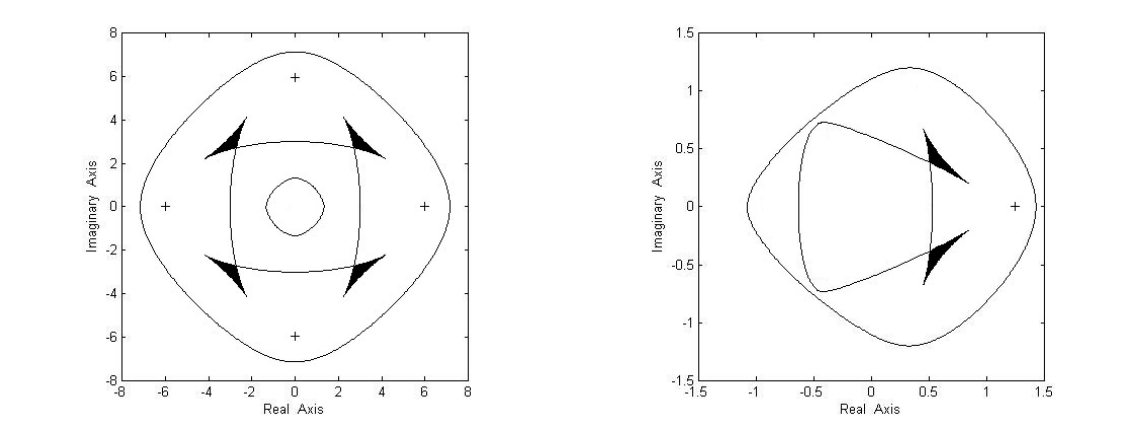
Figure 3. The sets F ( A ) ≡ Λ 1 ( A ) ⊇ Λ 2 ( A ) ⊇ Λ 3 ( A ) (left) and F ( B ) ⊇ Λ 2 ( B )